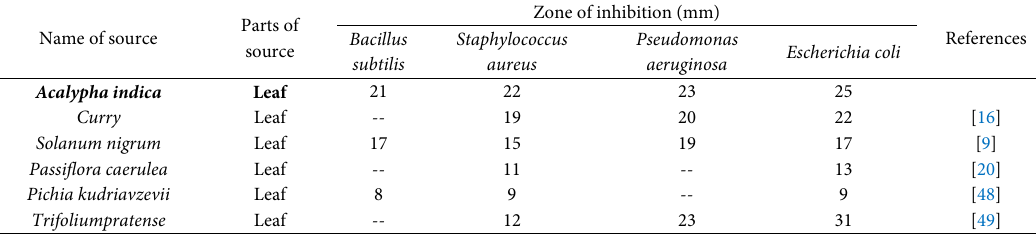
Table 4. Comparison of obtained antibacterial results of prepared samples with the